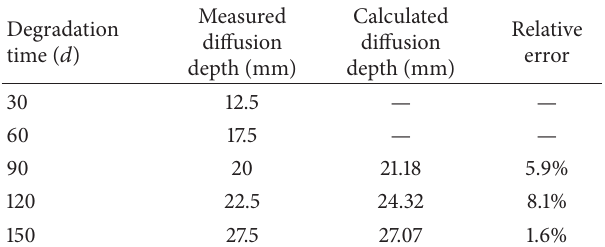
Figure 3: Prediction of Model (19) compared with the experimental results. Table 5: Experimental and calculated values of diffusion